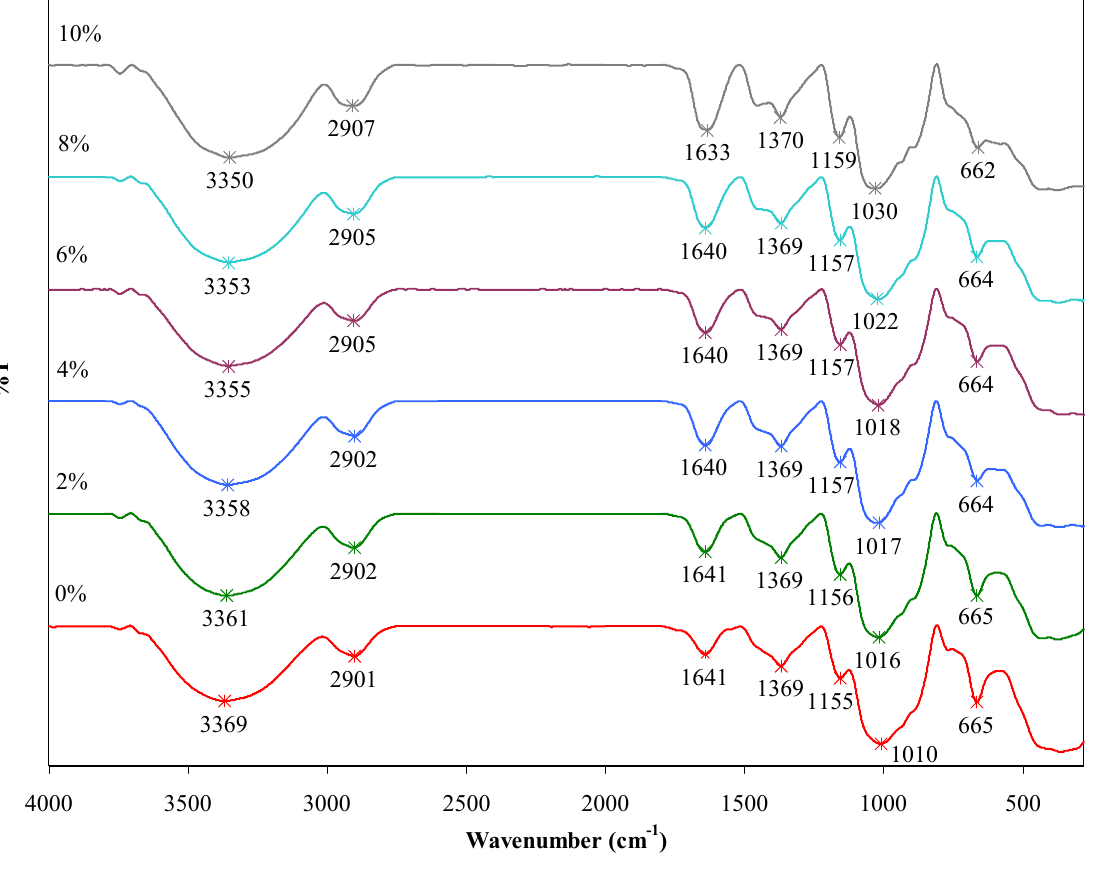
Table 3. FTIR bands of the agarose/talc composite